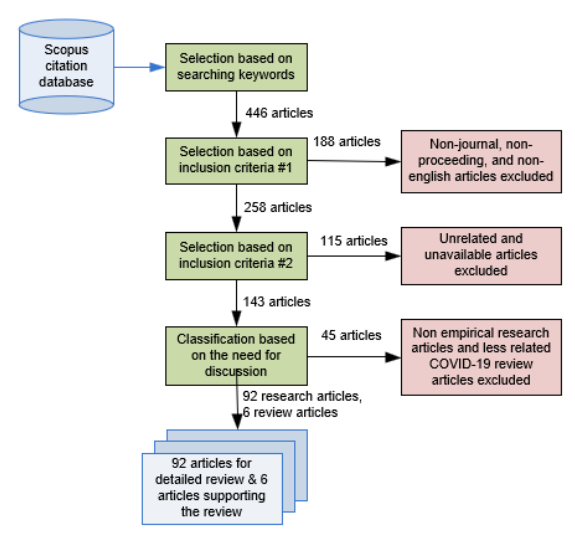
Figure 1. Literature review process.